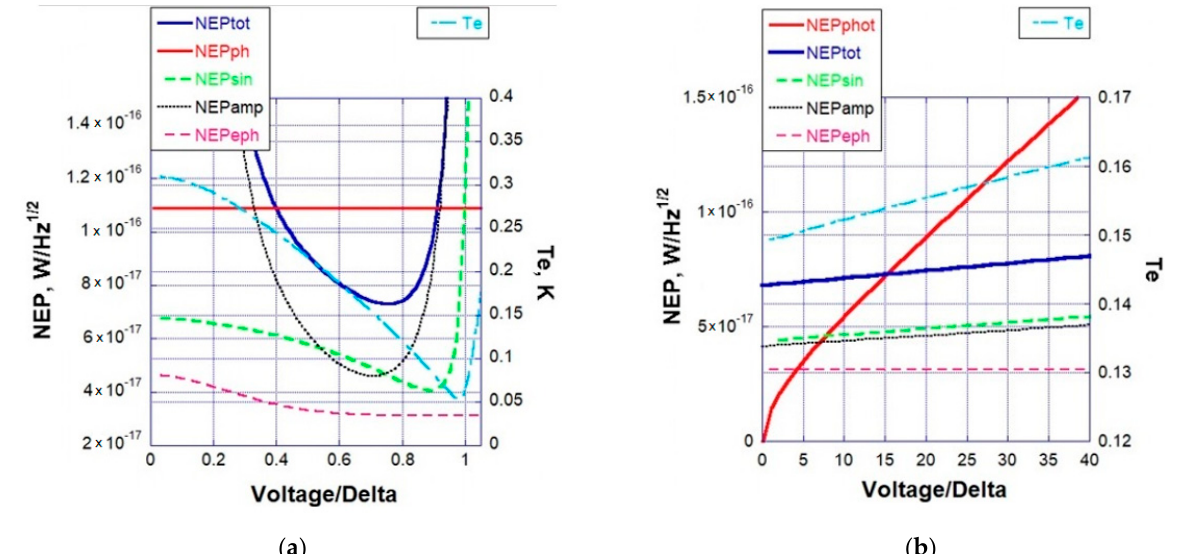
Figure 7. ( a ) NEP components for the 2D periodic array of cold-electron bolometers with 10 × 10 unit cells, each containing four bolometers incorporated into a ring. Electron temperature, Te, is shown for both cases referring to the right axis. Parameters: f = 350 GHz, Po = 20 pW Iamp = 5 fA/Hz 1/2 , Vamp = 5 nV/Hz 1/2 (JFET), R = 1 k Ω , Λ = 0.02 μ m − 3 , T = 300 mK, ( b ) dependence of the noise component and electron temperature on optical power of absorbed signal.